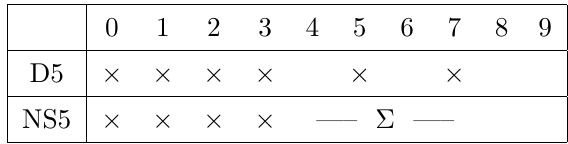
Table 1. The brane con(cid:12)guration of D5 and NS5